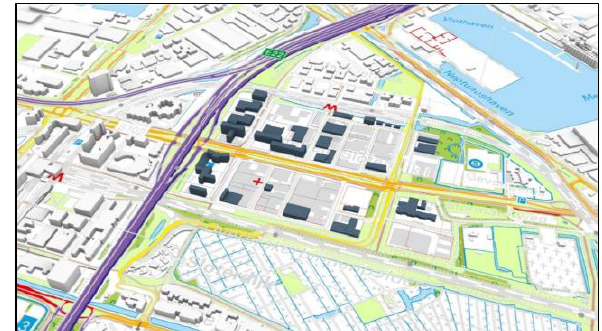
Figure 11. Example of visualisation of additional contextual information during the design process.